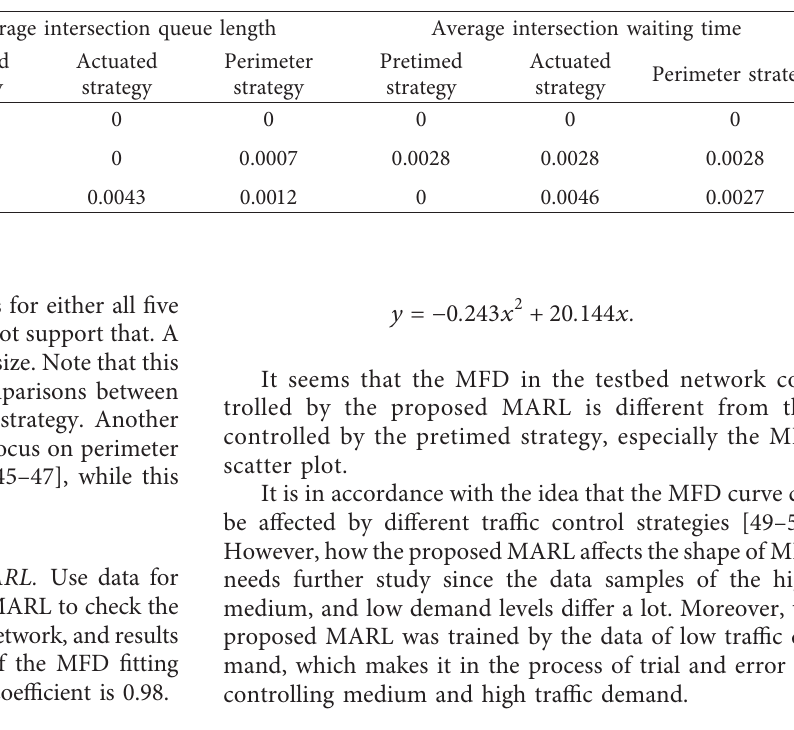
Table 2: Results of the Friedman test for different demand levels.